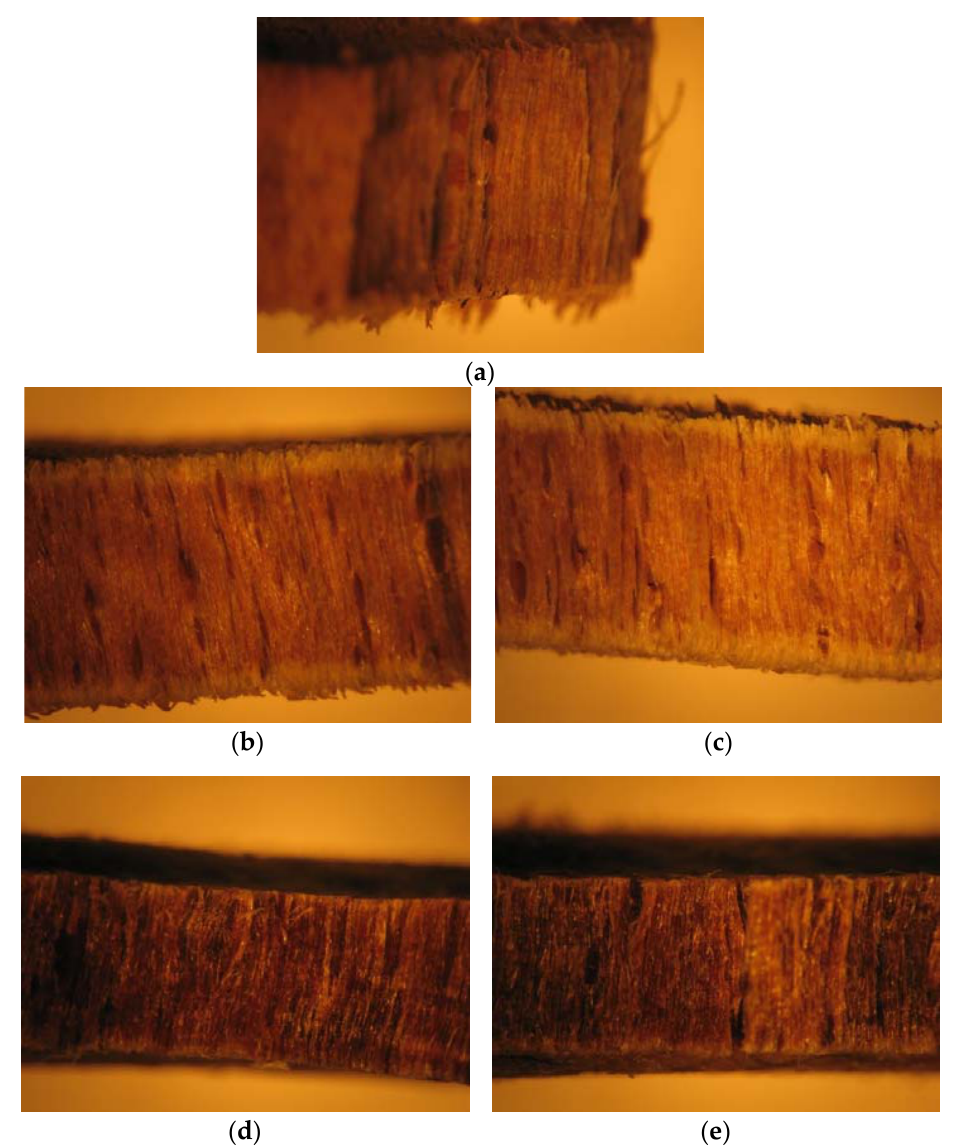
Figure 12. Fracture cross-section of the standard beech wood sample ( a ) and the samples immersed in 5% NaClO and 100% NaClO for three weeks ( b , d ) and three months ( c , e )